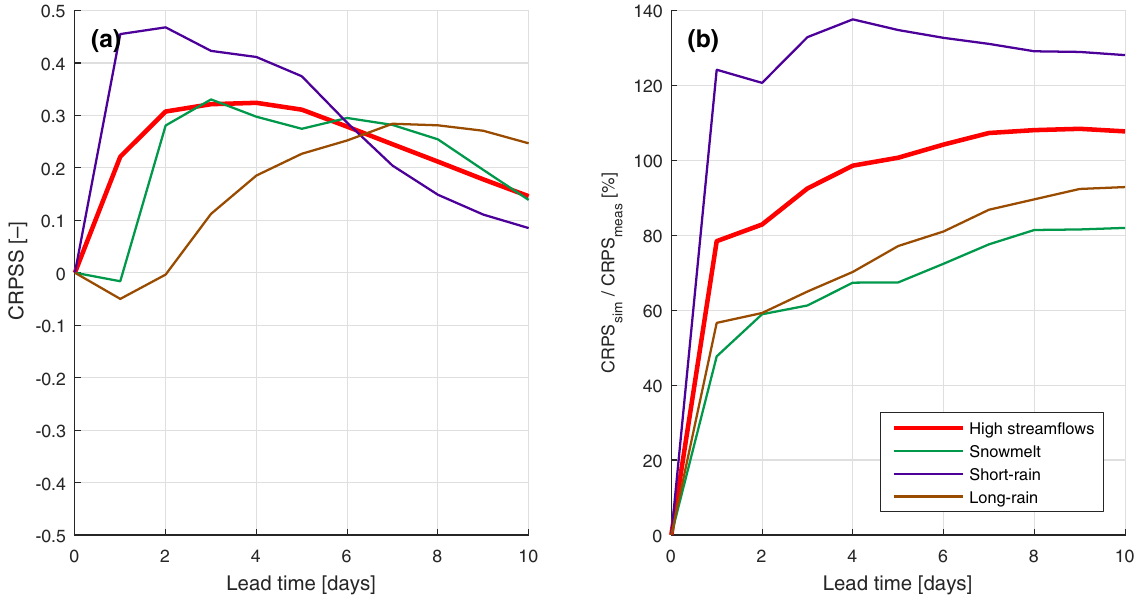
Figure 9. (a) Forecast skill of high-streamflow-generating processes. (b) Ratio of errors in meteorological forecasts (CRPS sim ) to meteoro- logical forecast + model errors (CRPS meas ).